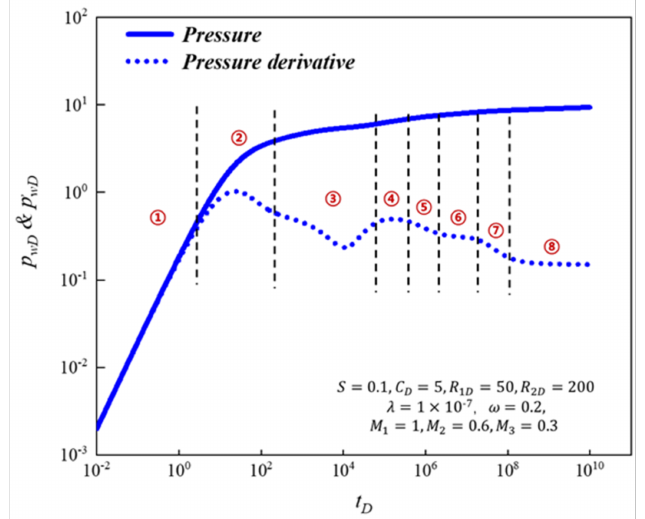
Figure 2. Type curves of two-phase flow considering in a fractured gas condensate